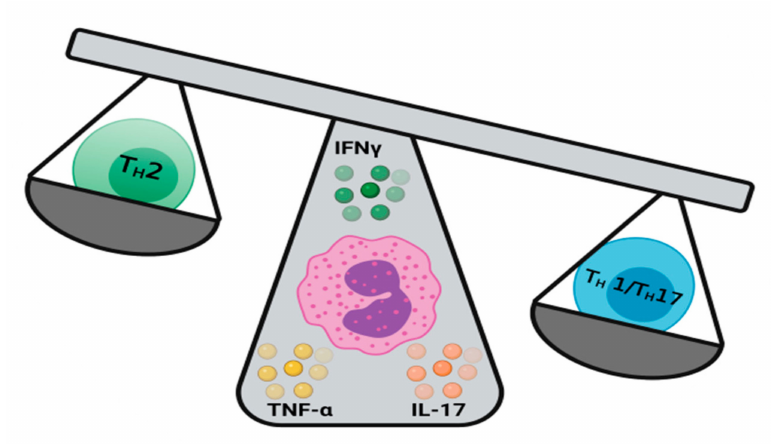
Figure 2. Eosinophils promote T H 1/T H 17 responses. Eosinophils contain and secrete cytokines, such as IFN γ , TNF α , IL-17, and others, generates a type I or type III immune response against external insults, such as viral